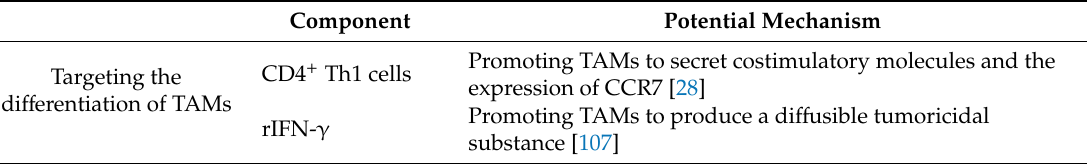
Table 4. Component Involved in the Switch from M2 to M1-like macrophages.